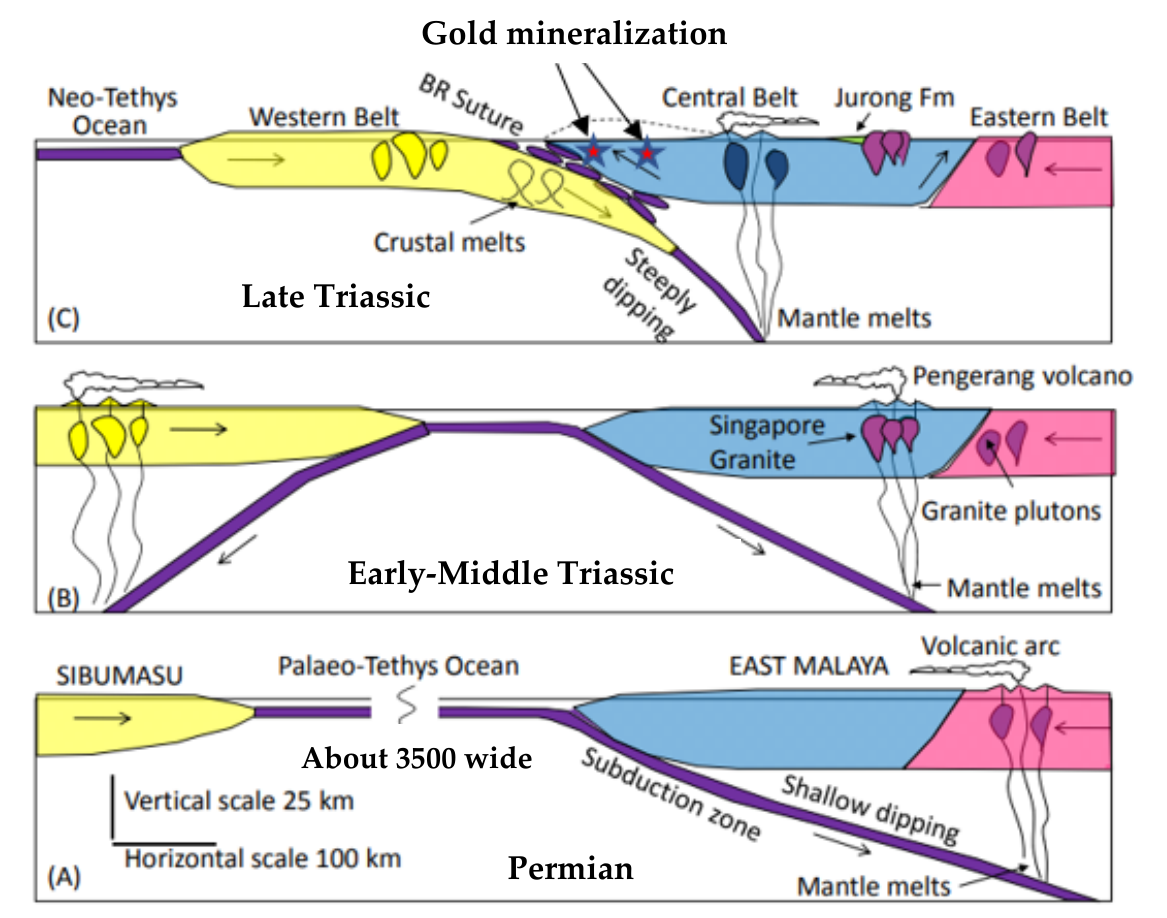
Figure 2. Geodynamics context for the formation of the Bentong-Raub (BR) Suture Zone in relation to the closure of the Paleo-Tethys Ocean (Modified from [37]). In late Triassic, several magmatic events favored the emplacements of S- and I-type granites across the suture zone. The collision of the Sibumasu and East Malaya blocks occurred in Late Triassic (200–230 Ma) to form the Bentong-Raub Suture Zone. Note ( A ) Permian (290–250 Ma). ( B ) Early-Middle Triassic (250–230 Ma). ( C ) Late Triassic (230–200 Ma).